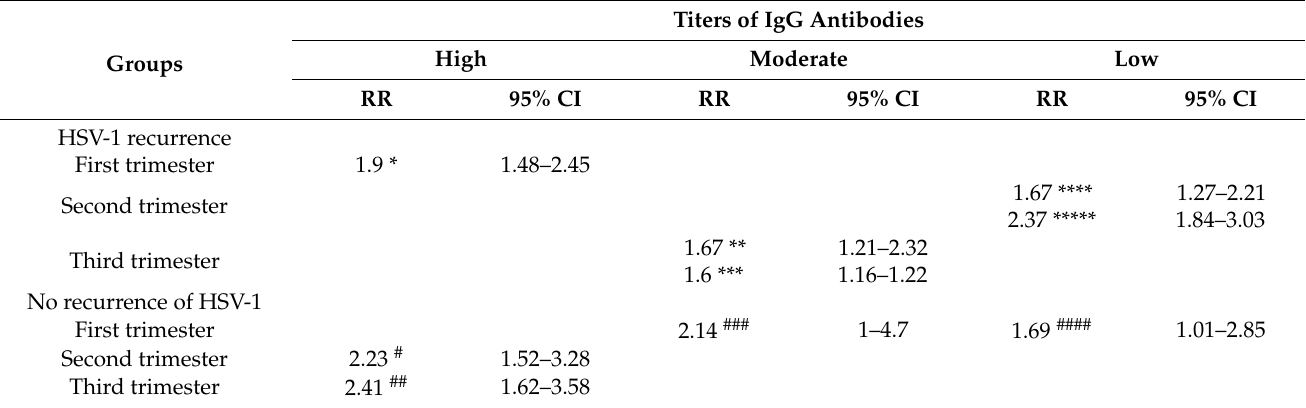
Table 4. Serological receptivity to HSV-1 infection in women at different stages of